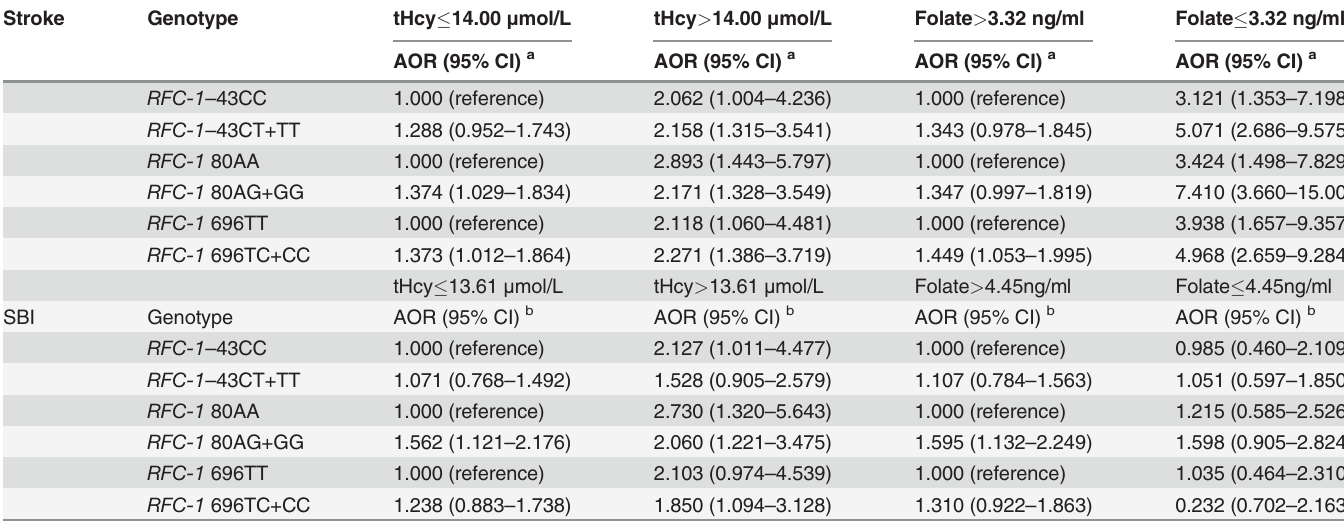
Table 5. Combined effects of genotype and homocysteine and folate levels upon ischemic stroke and silent brain infarction (SBI)